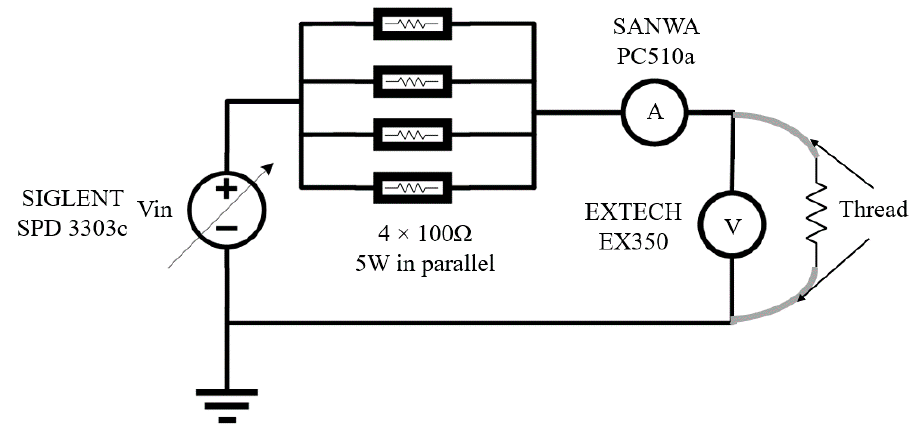
Figure 1. Schematic representation of the thread characterization circuit .